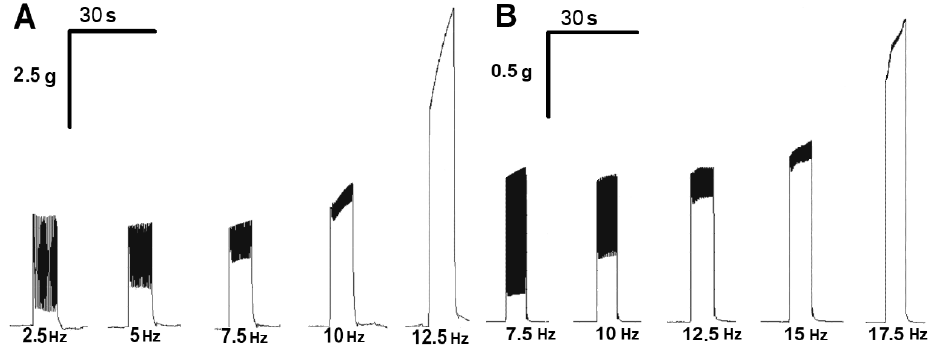
Figure 4. Records of contractions of m. soleus ( A ) and m. EDL ( B ) at different stimulation frequencies at 37 °C.